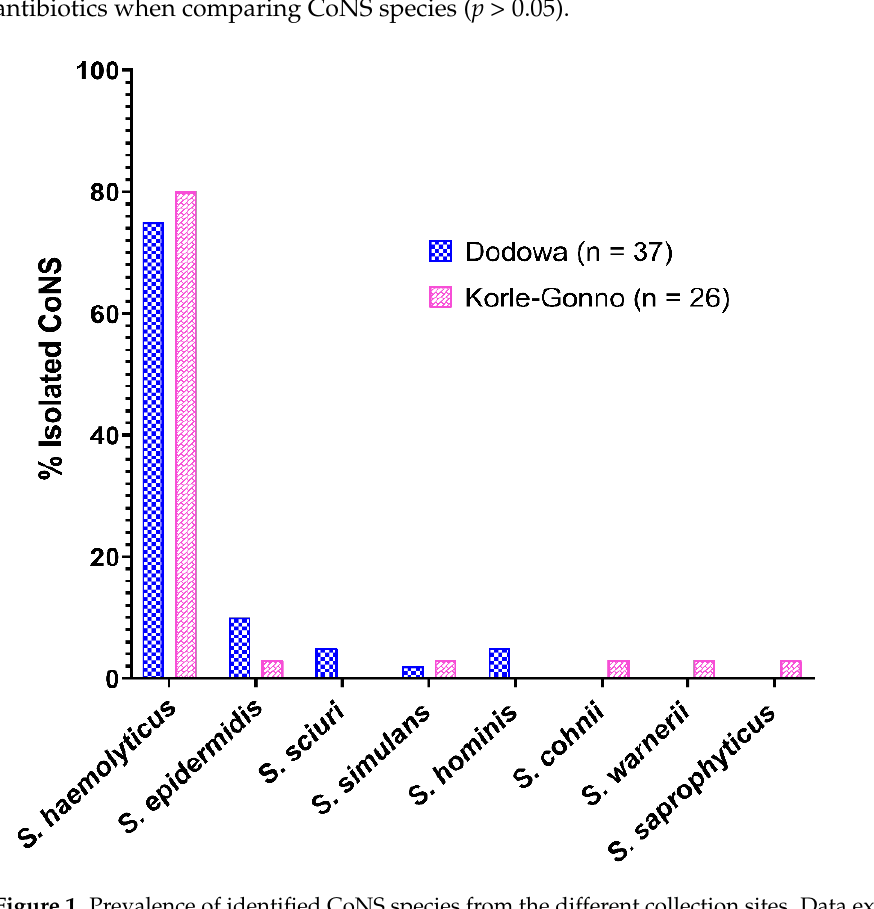
Figure 1. Prevalence of identified CoNS species from the different collection sites. Data expressed as proportions of the different CoNS species observed. Their differences were tested with Chi-square test and were found to be significantly different ( χ 2 = 23.11, df = 7, p = 0.0016). Table 1. Multiple drug resistance as observed by CoNS species.